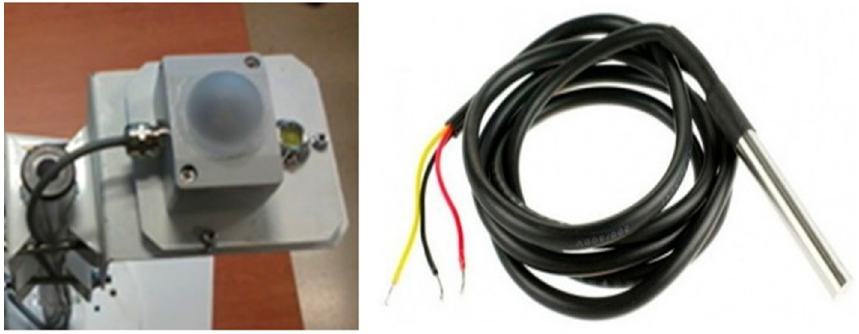
Figure 3. On the right, the sensor that measures Tamb; on the left, the sensor that measures G i